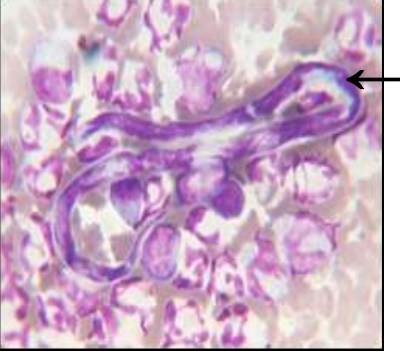
Figure-4. E. canis morulae in a monocyte Figure-5. Dirofilaria immitis microfilaria in